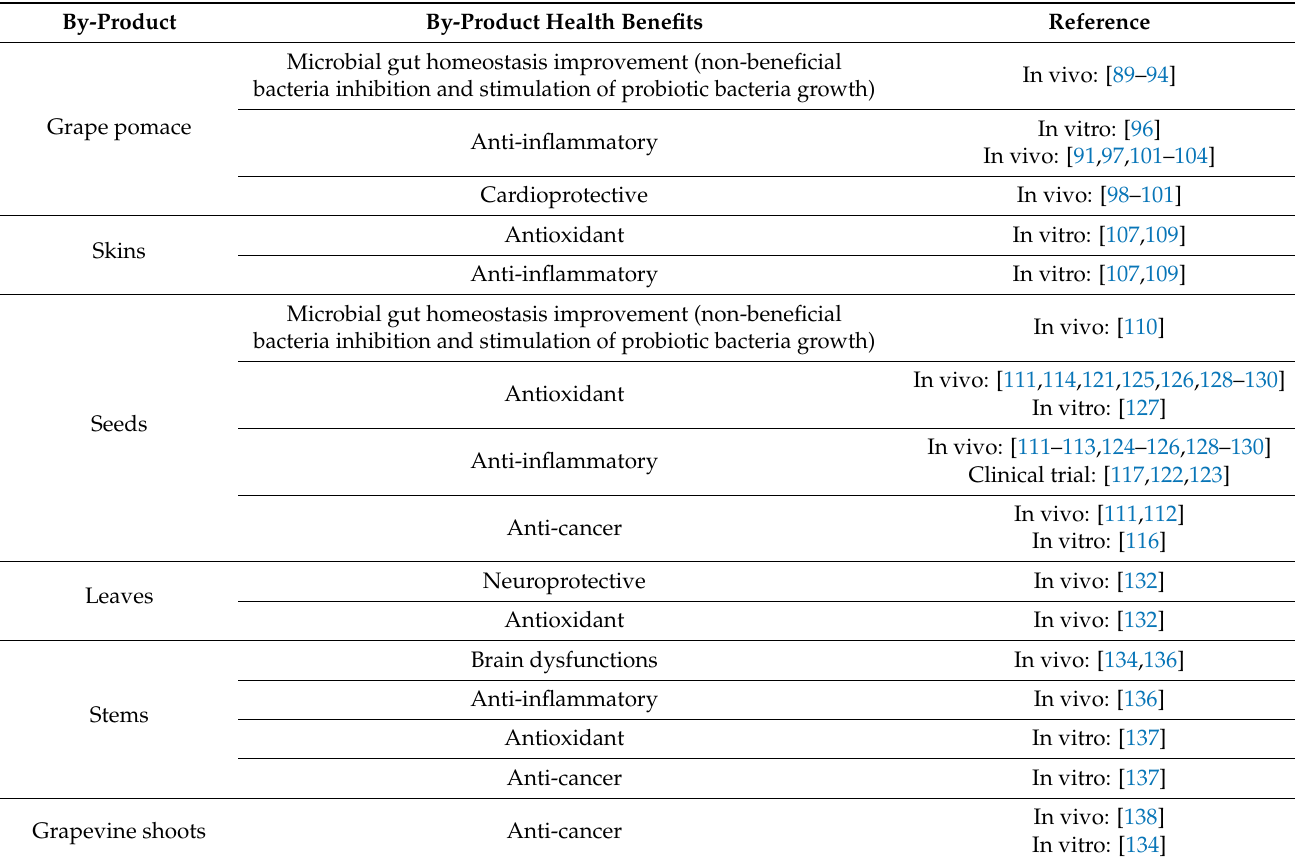
Table 2. Effects on body functions of food made with wine by-products or their extracts achieved in pre-clinical and clinical